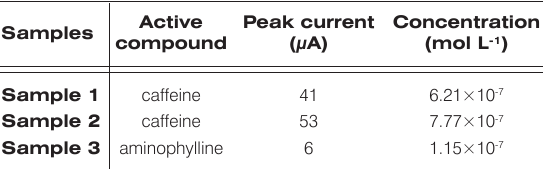
Table 4. Data obtained for human urine samples